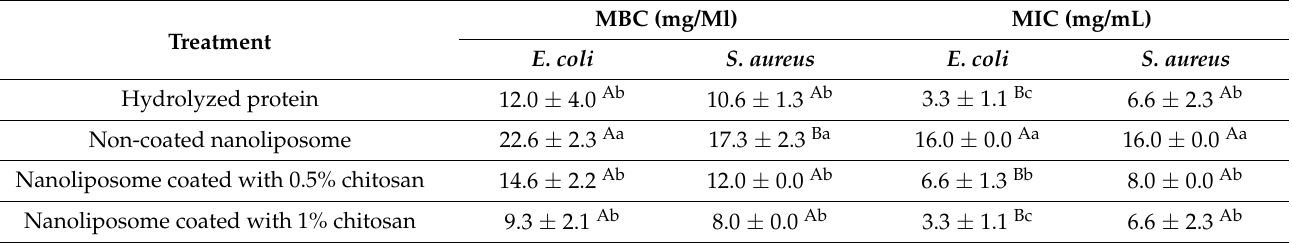
Table 2. MIC and MBC of 14% hydrolyzed protein and coated and non-coated nanoliposomes.